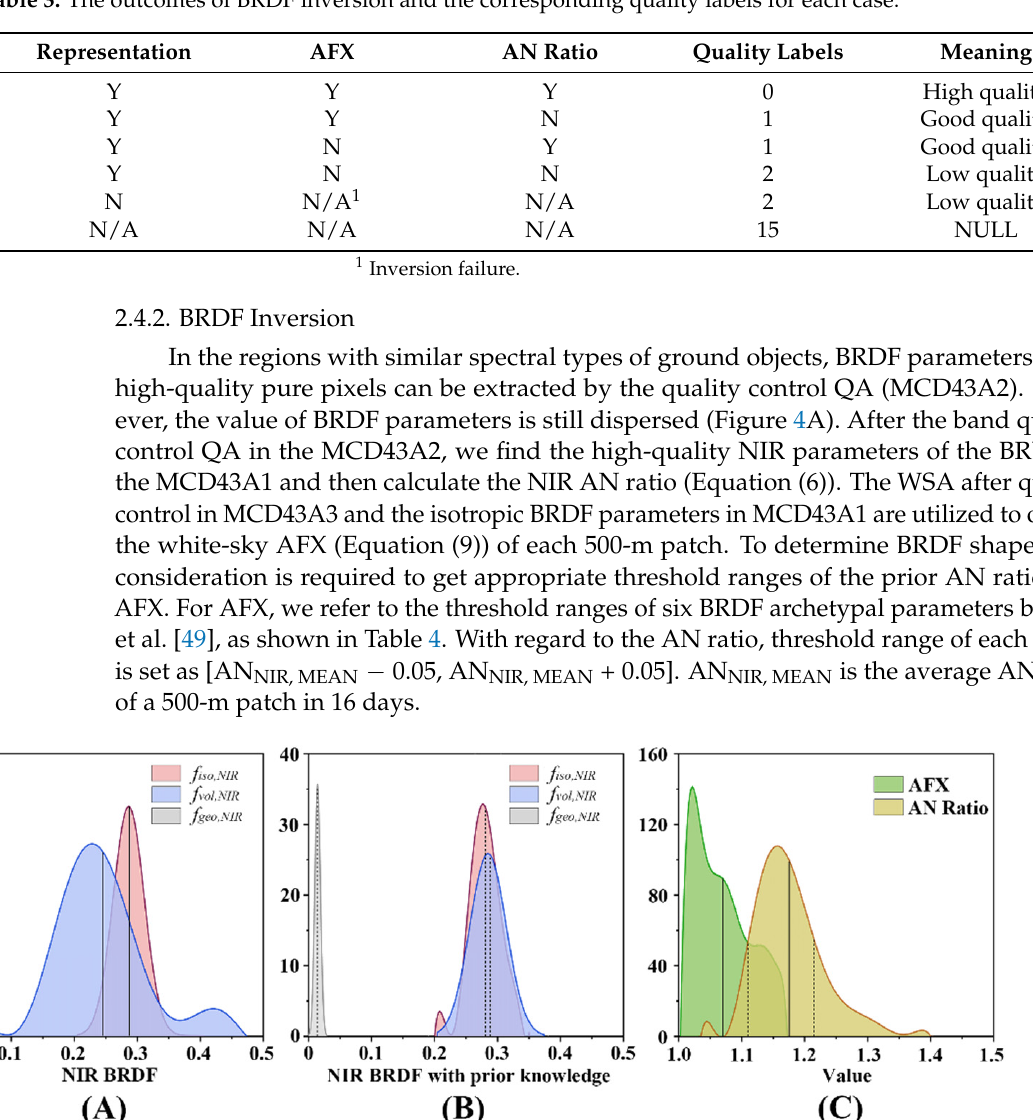
Table 3. The outcomes of BRDF inversion and the corresponding quality labels for each case.